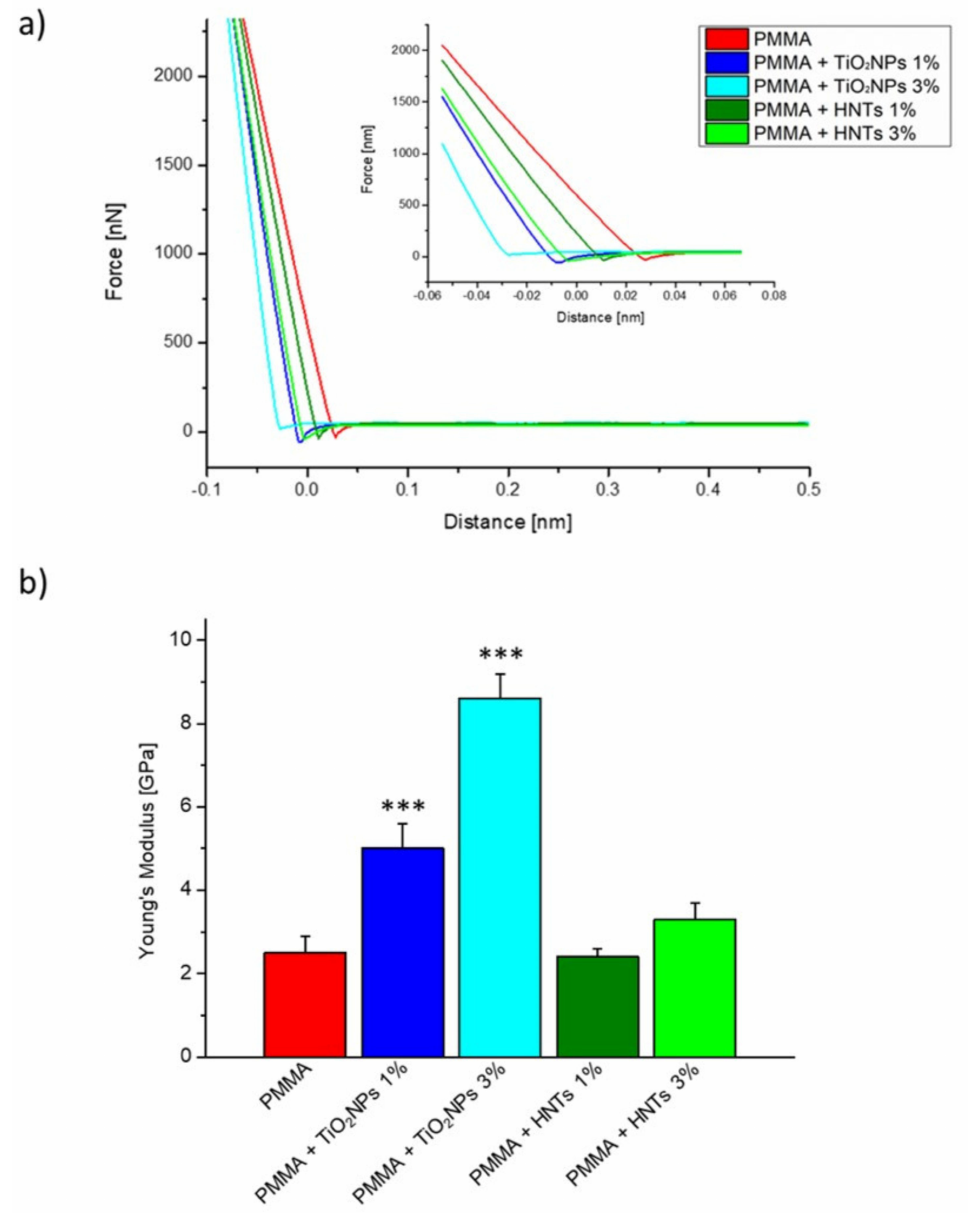
Figure 3. ( a ) Representative force-distance curves (only approach data portion) recorded on dif- ferent PMMA-based materials. In the histogram ( b ) the mean value and its standard deviation of Young’s Modulus, evaluated for control (PMMA), PMMA + TiO 2 NPs 1%, PMMA + TiO 2 NPs 3%, PMMA+ HNTs 1%, and PMMA+ HNTs 3% were represented. Reported results were considered statistically significant respect to control (PMMA) for p -value < 0.005